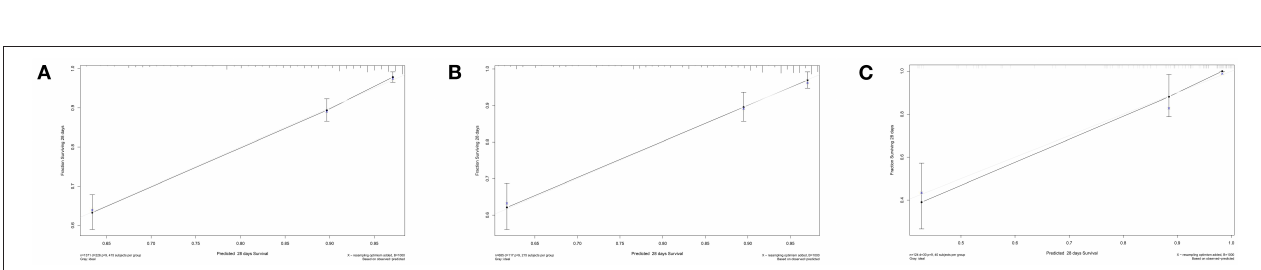
FIGURE 4 | The time-dependent receiver operating characteristics (ROC) curve and area under the ROC curve (AUC). (A) The ROC in the training cohort; (B) The ROC in the internal validating cohort; and (C) The ROC in the external validating cohort.